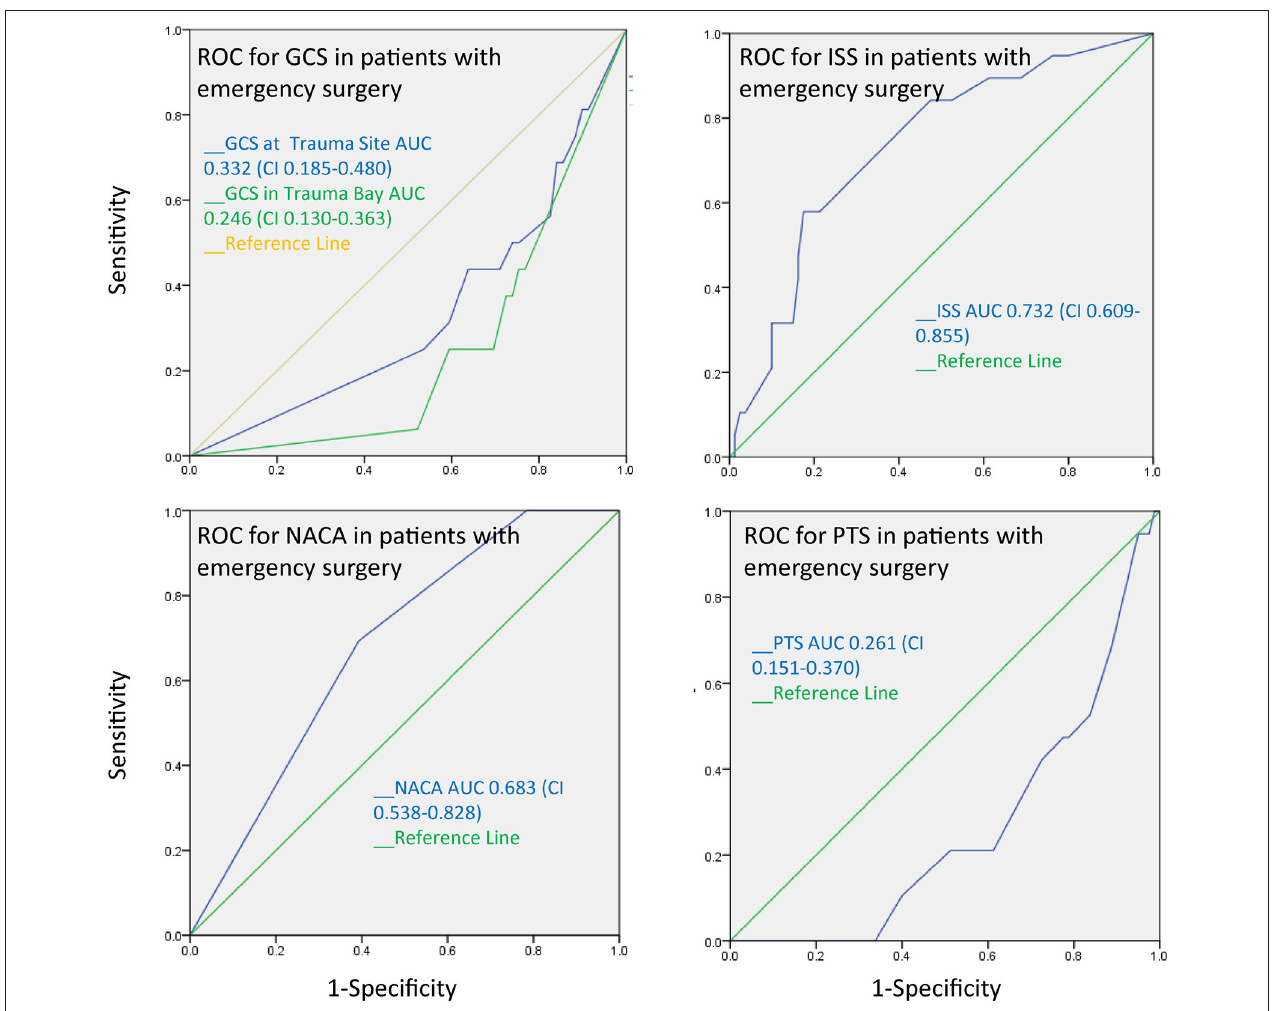
FIGURE 4 | The receiver operating characteristics curve for emergency surgery after trauma demonstrates that the ISS and the NACA score can discriminate between patients who patients who underwent emergency surgery and those who did not.